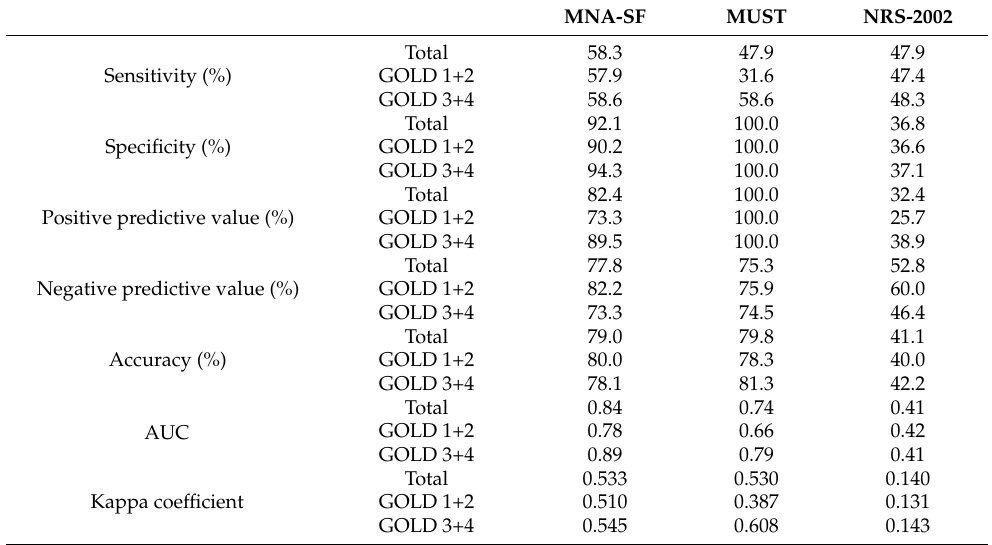
Table 3. Diagnostic performance of the MNA-SF, MUST, and NRS-2002